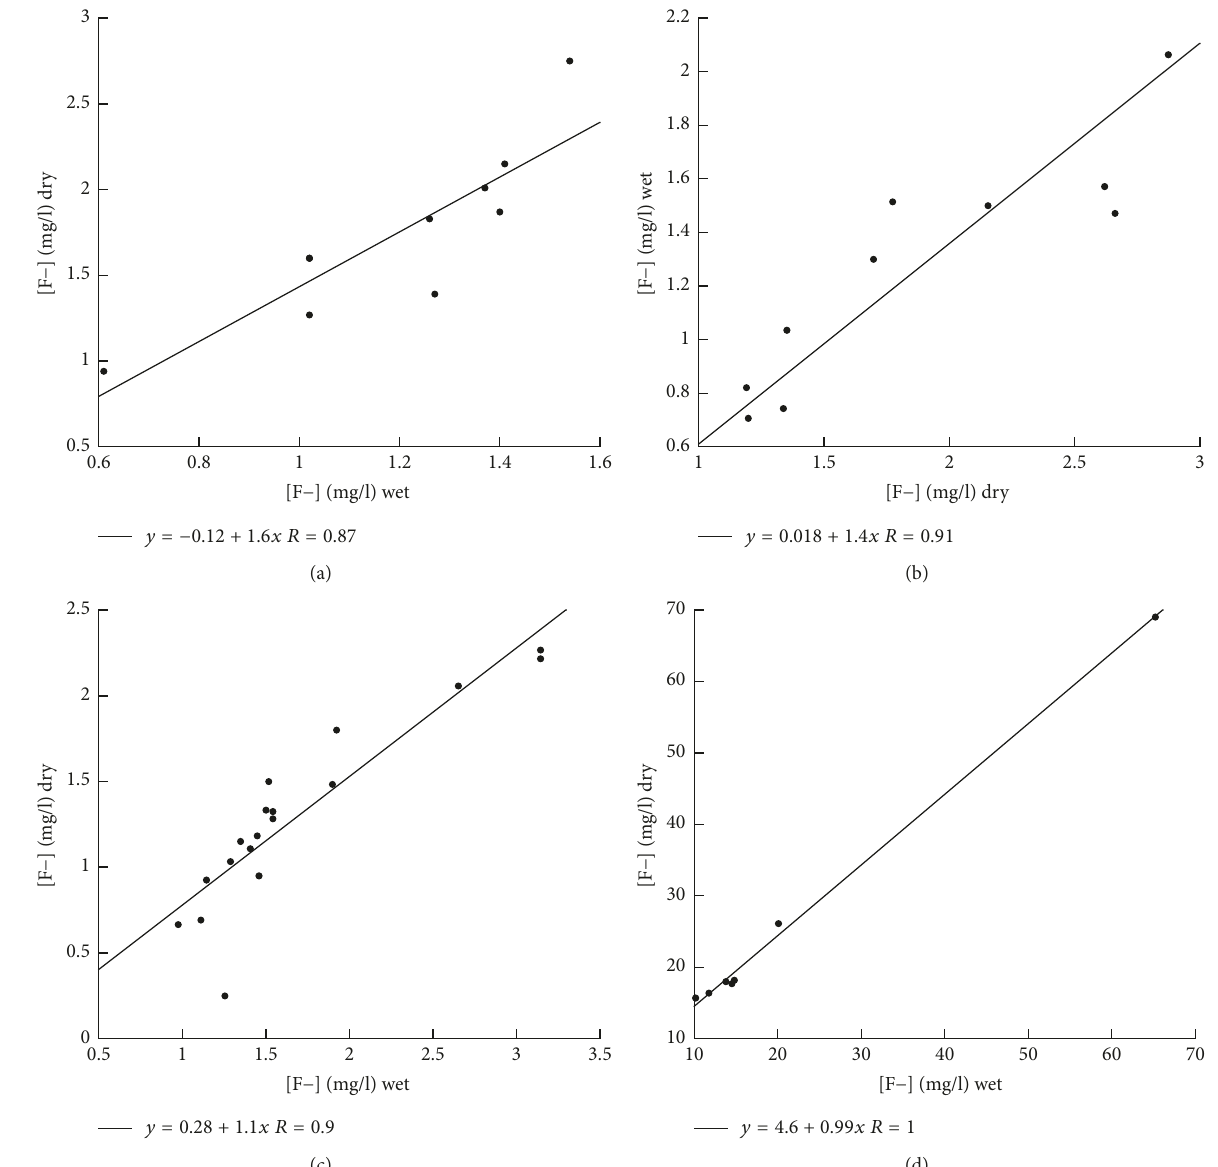
Figure 6: Correlation of fluoride between wet and dry seasons in (a) Temi, (b) Nduruma, (c) Tengeru, and (d) Maji ya